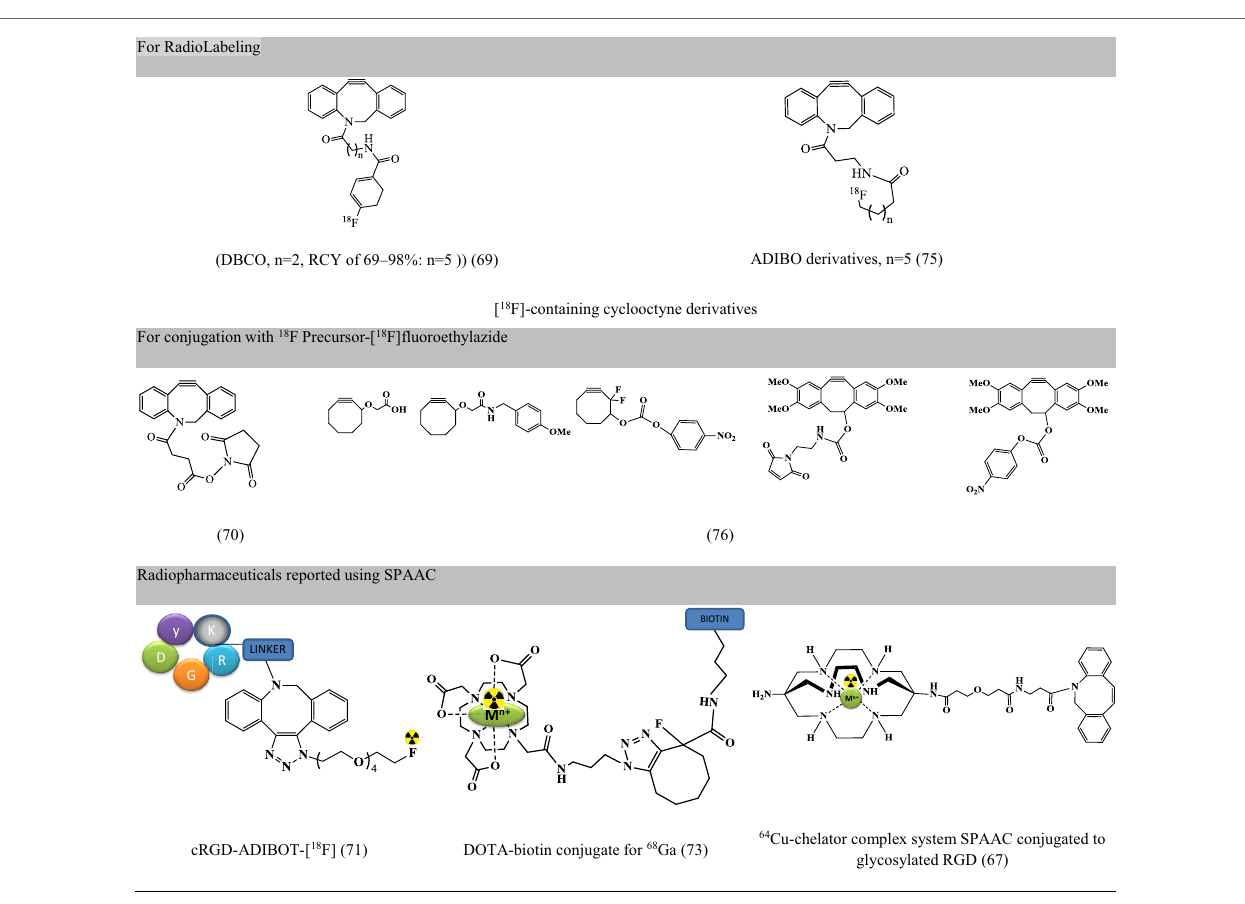
FiGURe 6 | Representative examples for radiopharmaceuticals using SPAAC. Structures referenced in (42, 67, 69–71, 73, 75,